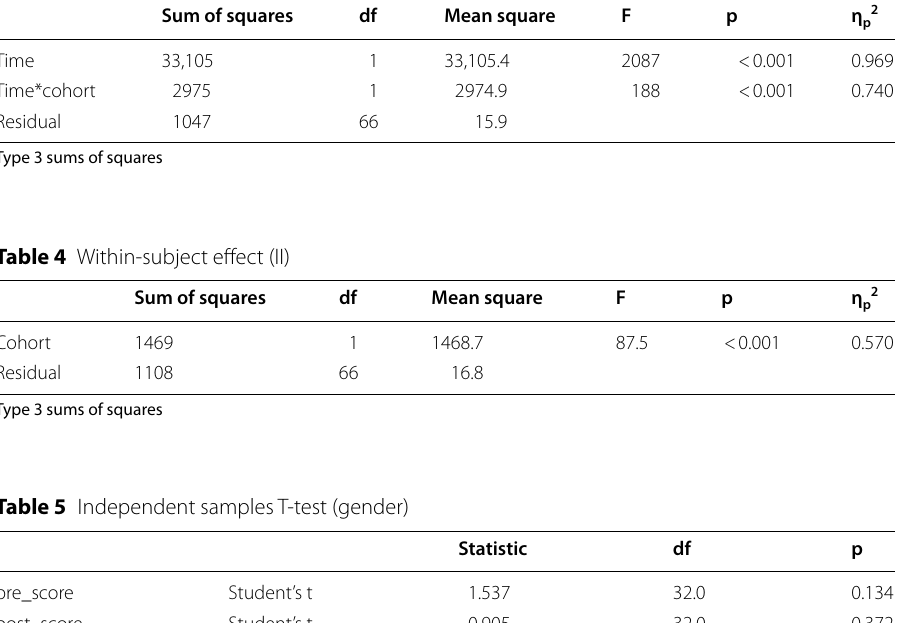
Table 3 Within‑subject effect (I)